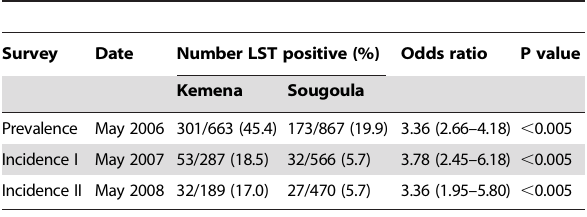
Table 2. Prevalence and annual incidence of Leishmania infection, determined using the leishmanin skin test (LST), in individuals living in the villages of Kemena and